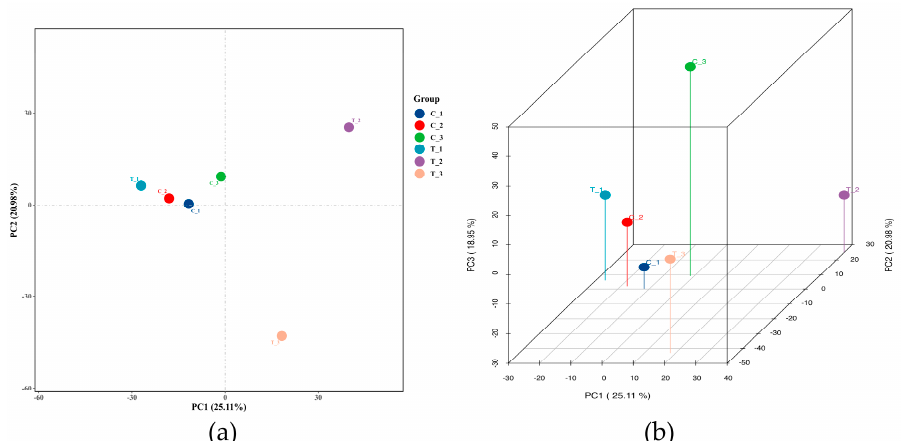
Figure 3. lncRNA expression analysis of TiO 2 NPs with a concentration of 0 and 100 μ g/mL. Princi- pal component analysis (PCA) 2D ( a ) and 3D ( b ) plots were drawn based on the expression of trusted lncRNAs to compare the difference between the control and the treatment groups.